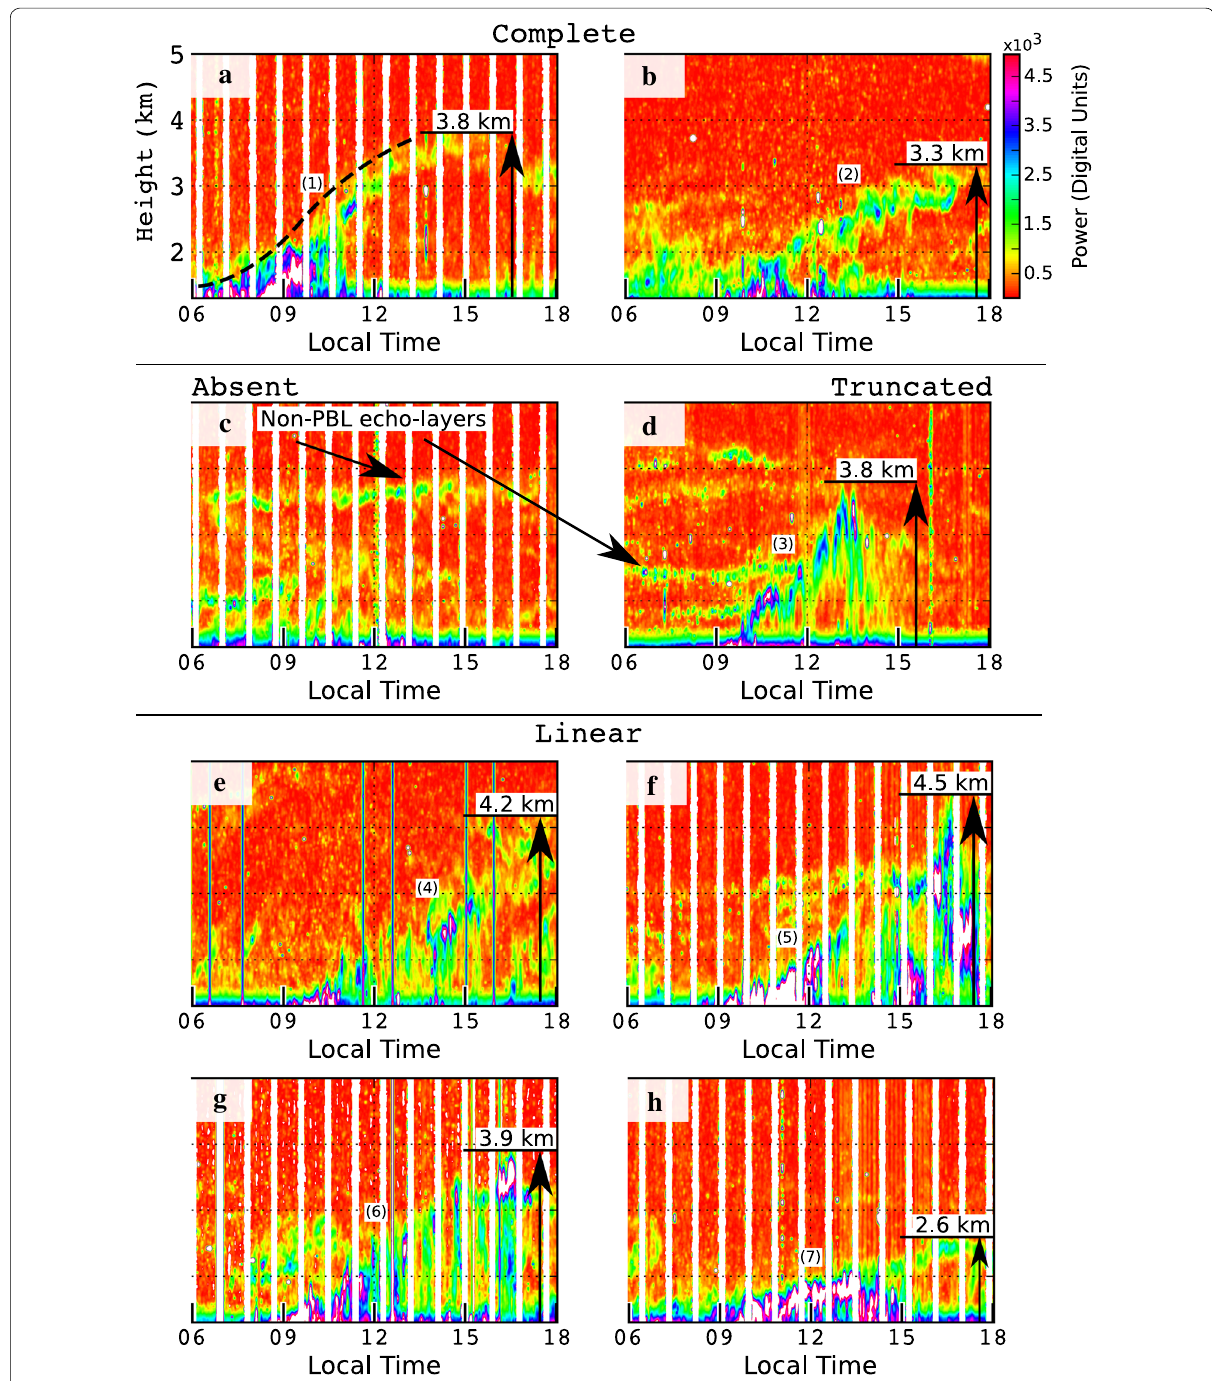
Fig. 4 Typical common echo layer structures. Eight different cases of likely PBL evolution are shown, labeled (1) to (7). Panels a and b [cases (1) and (2)] correspond to continuous growth with full development of the PBL echoes as observed on February 18th, 2014 and December 28th, 2013, respectively. Panel c shows the case of February 8th, 2014 where no observable PBL echoes were found. Panel d) contains a case of truncated linearly growing PBL echoes (3) observed on April 7th, 2014. Cases for January 9th, May 4th, March 11th and February 13th (2014 for all the cases) are presented in panels e , f , g , and h , as (4), (5), (6), and (7), respectively, and exemplify linear growth of the echoes at the top of the PBL top. Note that the layers generally have different ascension